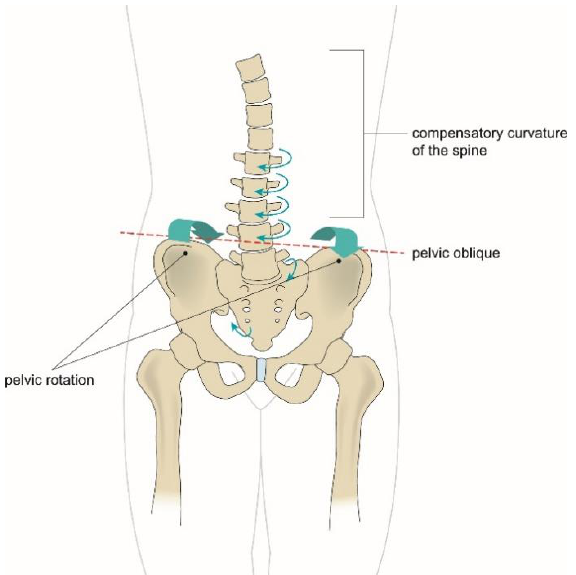
Figure 5. Asymmetrical alignment of the pelvic bone, compensatory curvatures of the spine, and asymmetrical ranges of motion of the pelvis in transverse and coronal planes.